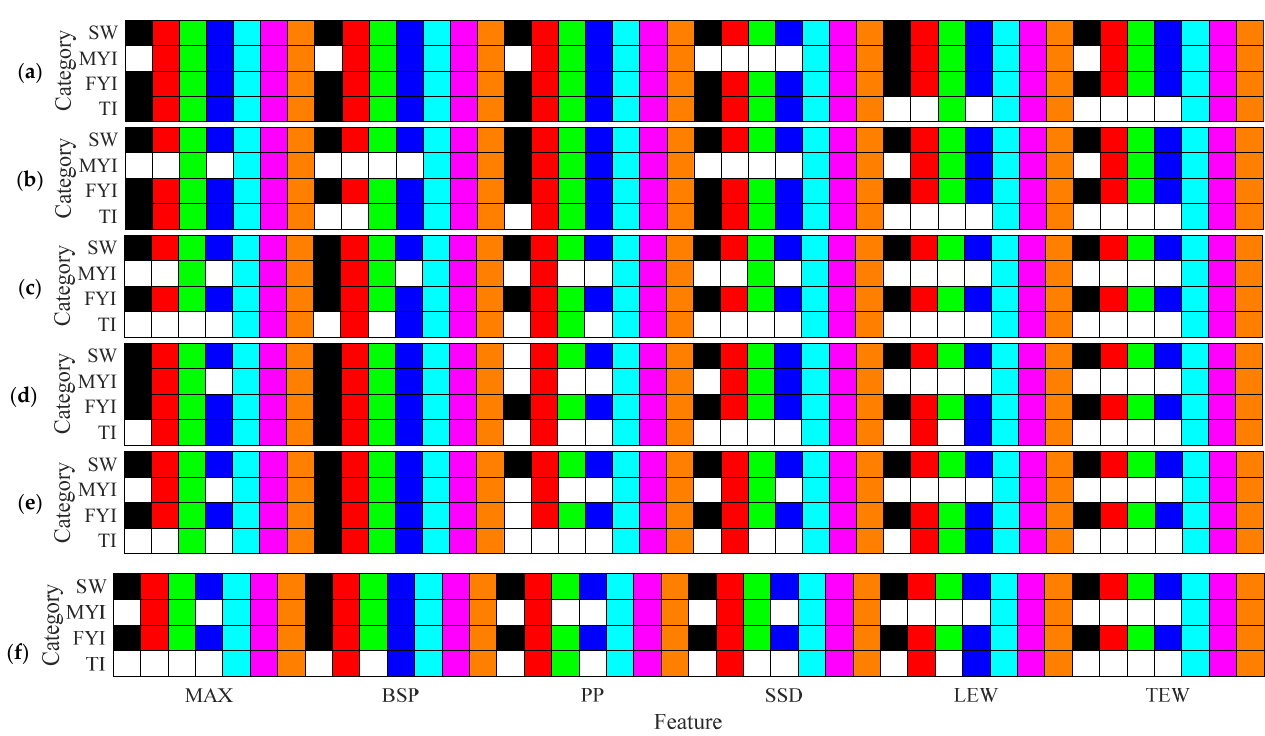
Figure 11. Recognition rates of a single feature of the KNN and SVM settings. Color squares represent recognizable categories by the features, white squares represent unrecognizable categories. ( a ) 0 ◦ ; ( b ) 2 ◦ ; ( c ) 4 ◦ ; ( d ) 6 ◦ ; ( e ) 8 ◦ ; ( f ) 10 ◦ . Table 4. Overall accuracies of waveform features at small incidence angles using the Euclidian dis- tance.